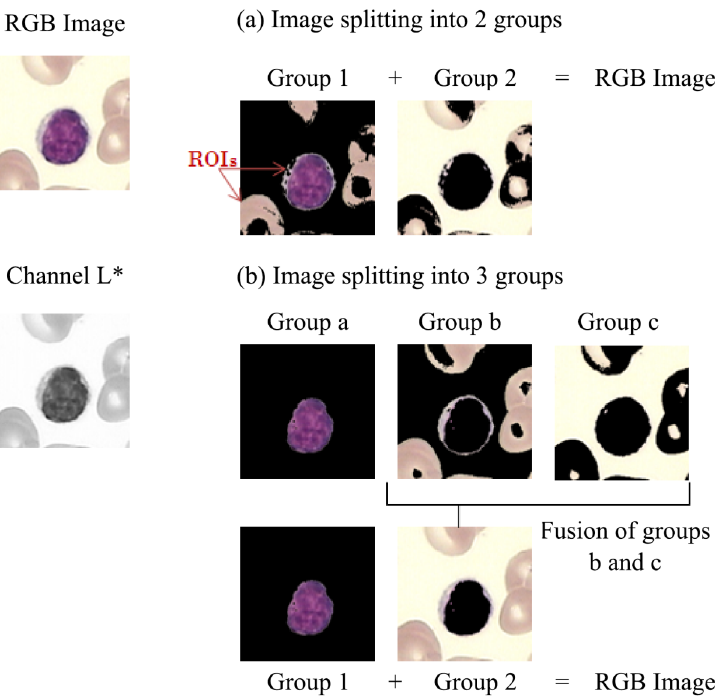
Fig 3. Groups creation using similarity features from a channel